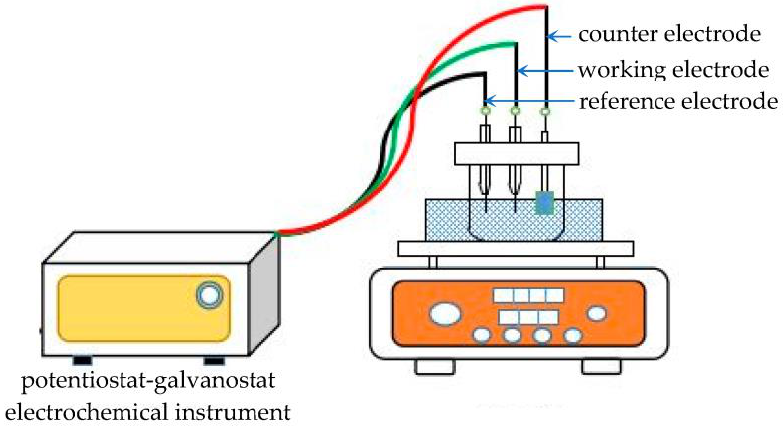
Figure 1. Schematic representation of the electrochemistry and electrodeposition experiment appa-